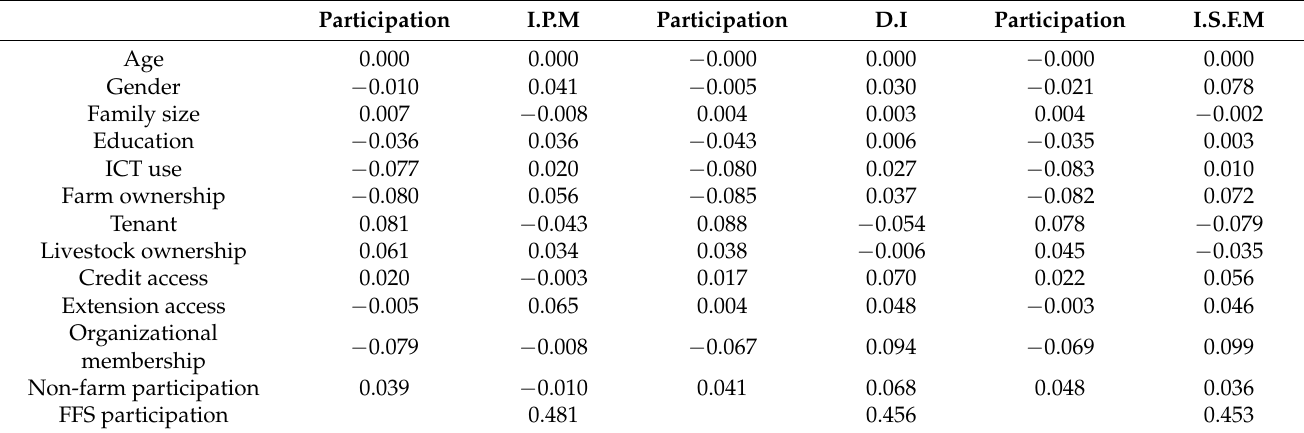
Table 5. Marginal effects of RBP model estimation on the marginal probability of adopting